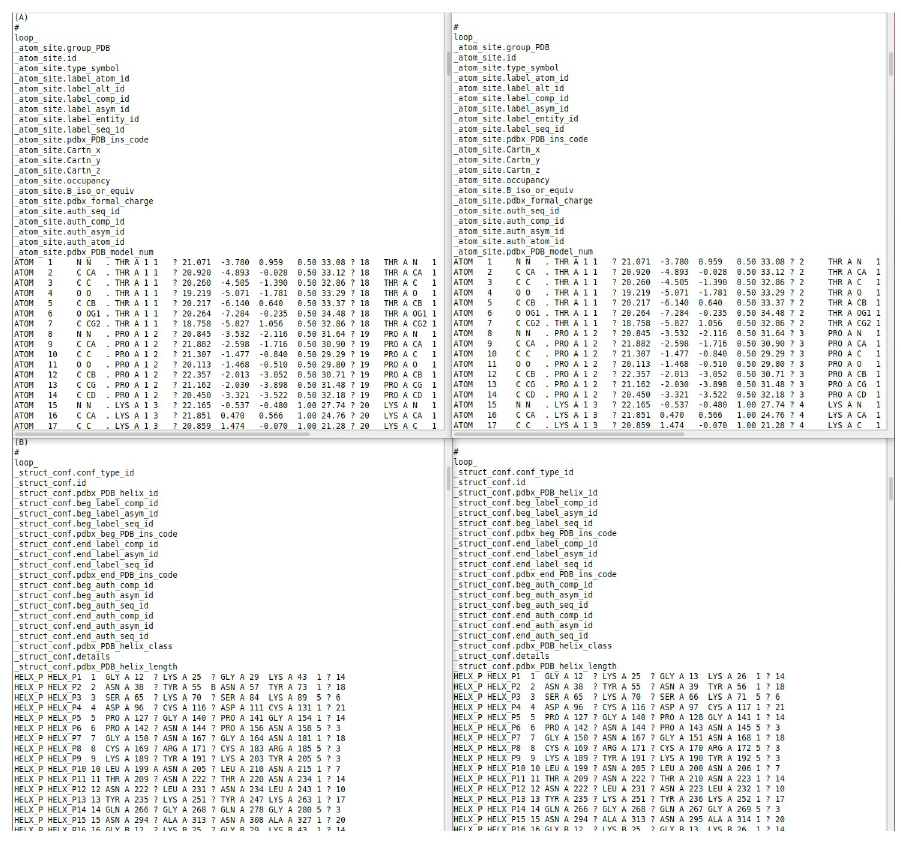
Fig 5. Renumbering PDB entry 2aa3. Screenshot of files 2aa3 before (left) and after (right) PDBrenum: “_atom_site” (coordinate section) (A) and “struct_conf” (B). Green arrows pointed to the columns which were changed.